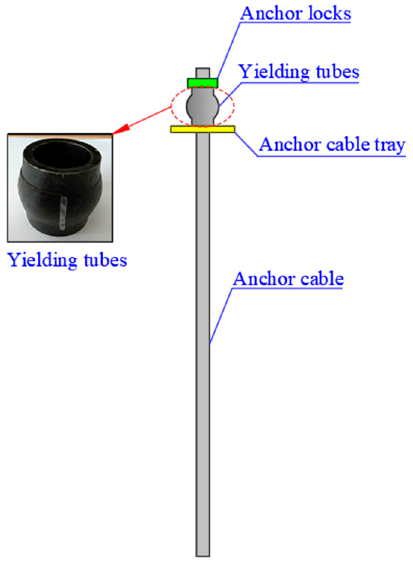
Figure 12. Yielding anchor cable.